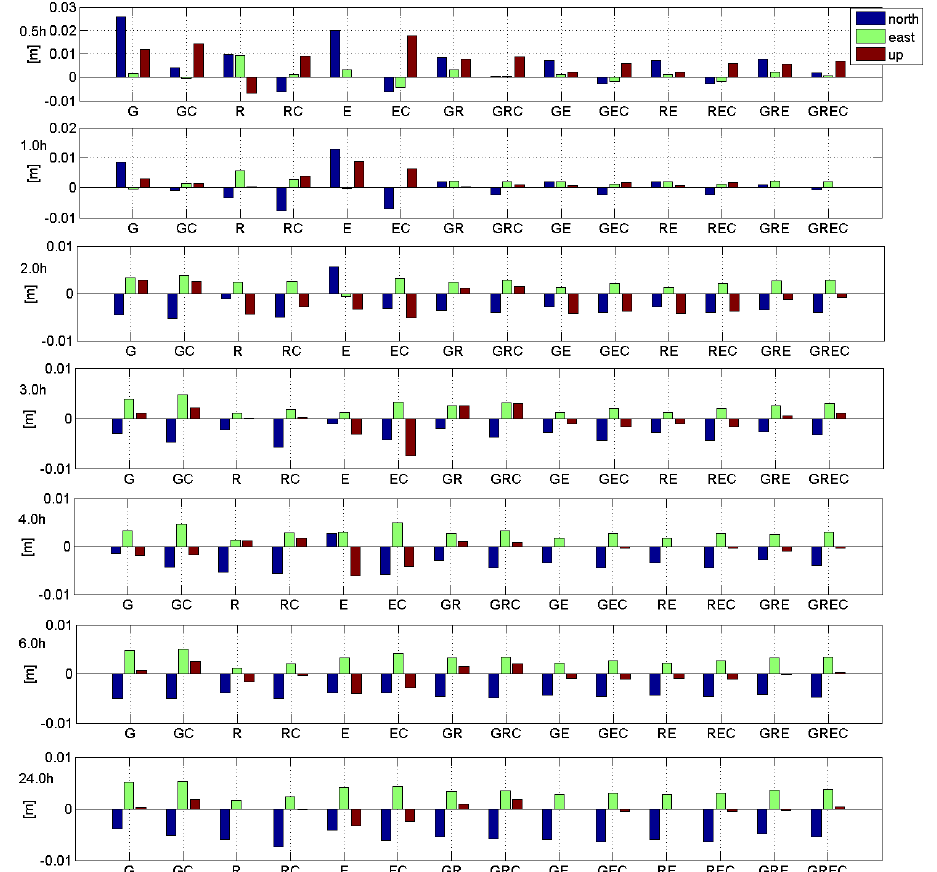
Figure 9. Mean position components differences (AUBG station): from 0.5 h session to 24 h session. Please note three different scales on vertical axis.